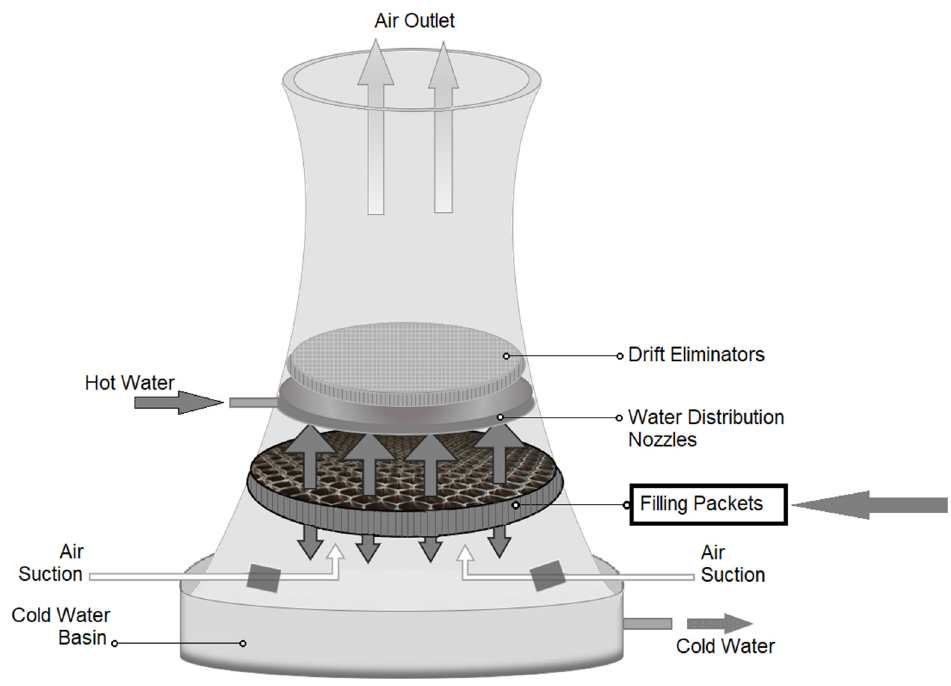
Figure 1. Schematic view of the natural draft cooling